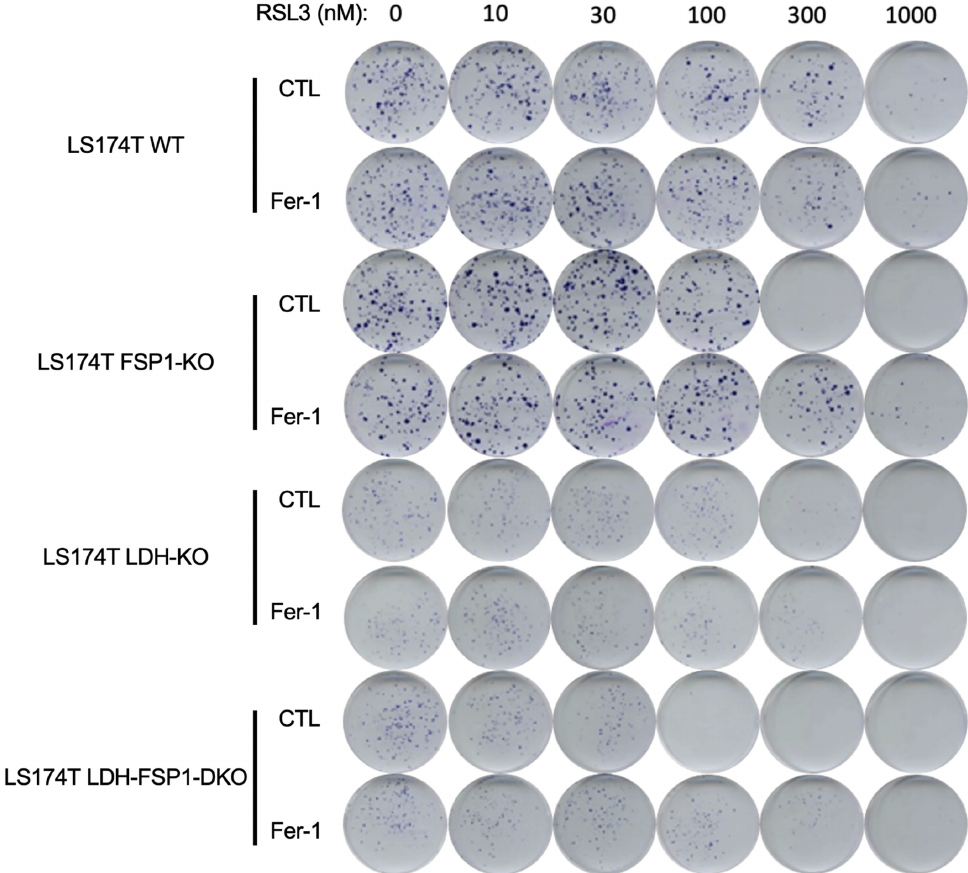
Figure 5. The effect of pharmacological inhibition of GPX4 in LS174T cells with WT, LDH ‐ KO, FSP1 ‐ KO or LDH ‐ FSP1 ‐ DKO genetic background. Cells were cultivated 14 days in DMEM media supplemented with increasing concentration of RSL3 (0, 10, 30,100, 300, 1000 nM) in the presence or not of 4 μ M Fer ‐ 1. At the end of the experiment, colonies were colored for visualization using Giemsa. Representative images are shown.